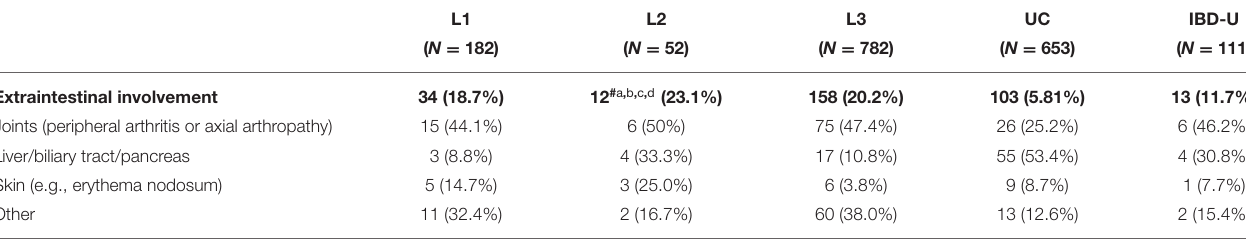
TABLE 2 | Extraintestinal manifestations with diagnosis.